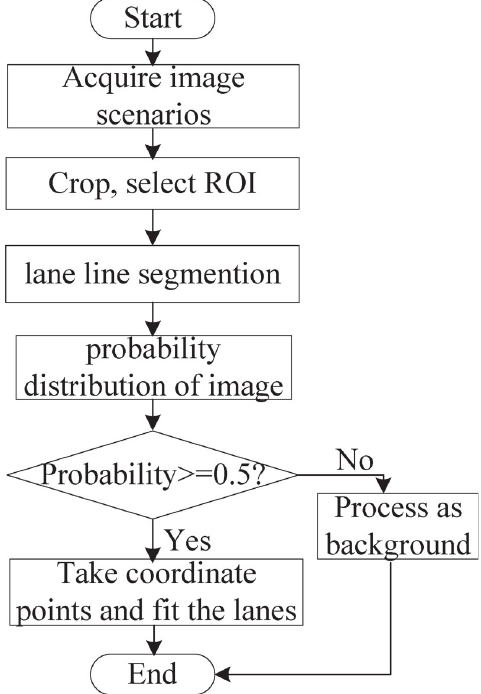
Fig 5. Flow chart for lane detection. The process involves three steps, including image preprocessing, lane line segmentation and lane line fitting.